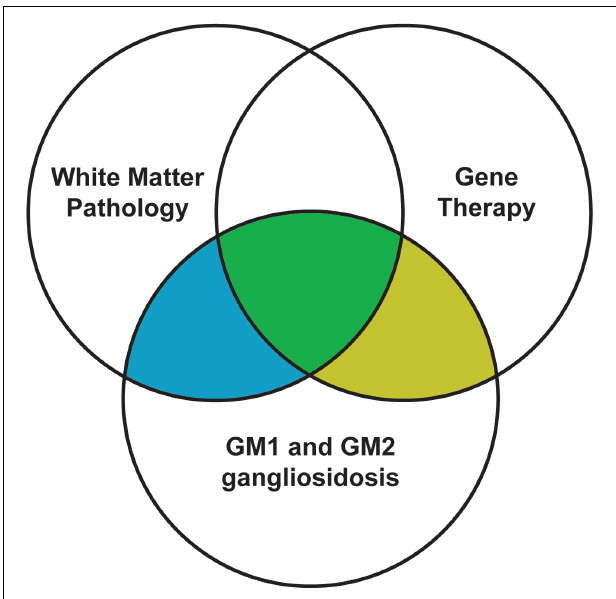
FIGURE 1 | Scope of this review. Filled areas are included in this review, while unfilled areas are covered